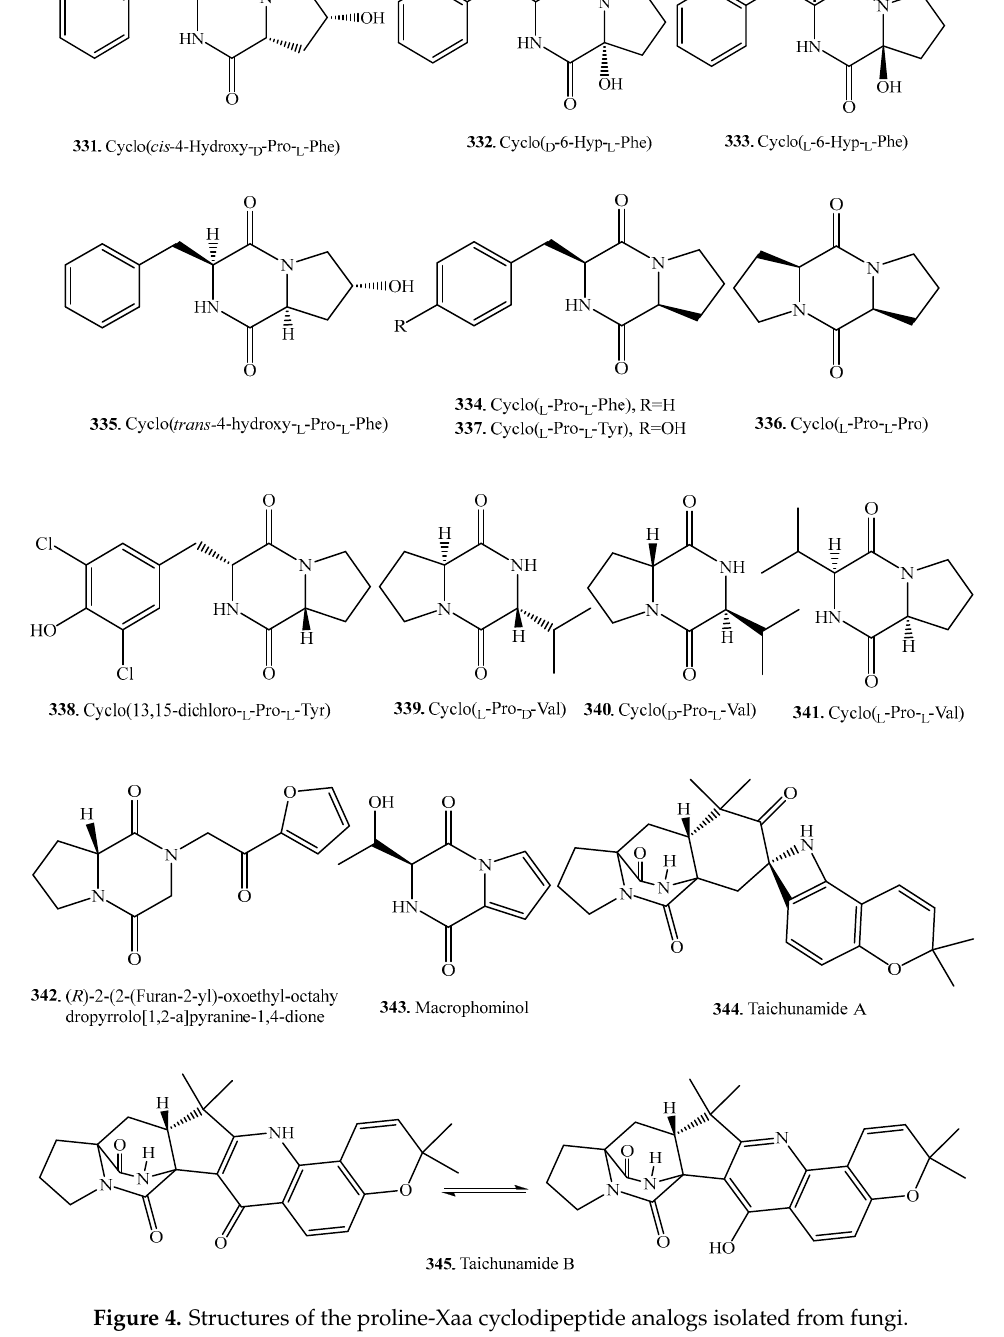
Figure 4. Structures of the proline-Xaa cyclodipeptide analogs isolated from fungi.